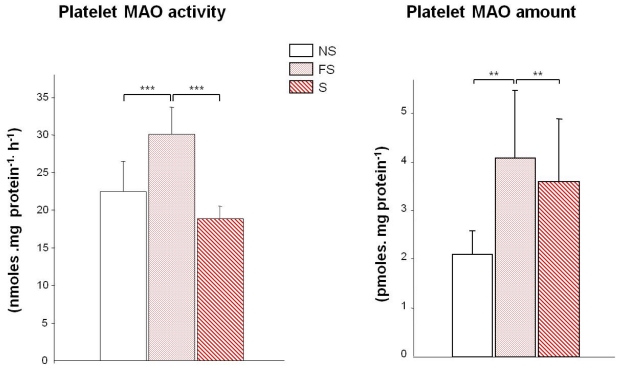
Platelet MAO in smokers (44 S), non smokers (34 NS) and former smokers (37 FS). Left: MAO activity (nmoles.mg protein−1h−1) Right: MAO amount (pmoles.mg protein−1). **P < 0.001, ***P < 0.00001.